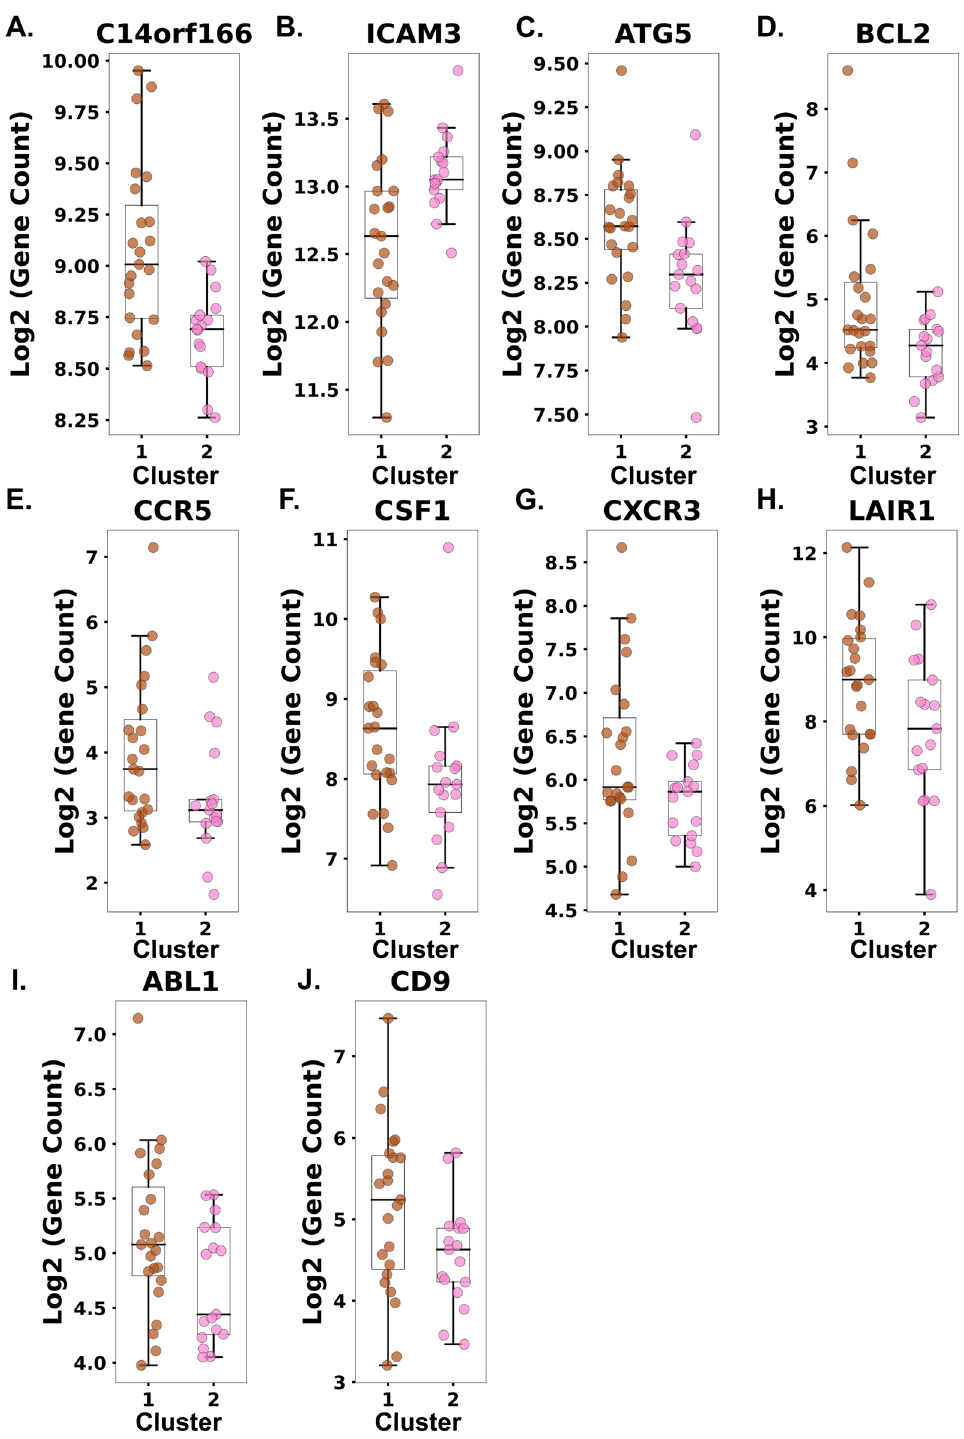
Figure 4. Box and whisker plots of the top ten differentially expressed genes by cluster from baseline (unstimulated) neutrophils. The middle line is the median, the bottom and top box edges are the 25th and 75th percentiles, respectively, and the whiskers are the minimum interval. ( A ) C14orf166, ( B ) Intercellular adhesion molecule 3 (ICAM3), ( C ) Autophagy-Related Gene 5 (ATG5), ( D ) B-cell lymphoma 2 (BCL2), ( E ) C–C chemokine receptor type 5 (CCR5), ( F ) Colony Stimulating Factor 1 (CSF1), ( G ) C–X–C Motif Chemokine Receptor 3 (CXCR3), ( H ) Leukocyte Associated Immunoglobulin Like Receptor 1 (LAIR1), ( I ) ABL Proto- Oncogene 1, Non-Receptor Tyrosine Kinase (ABL1), ( J )